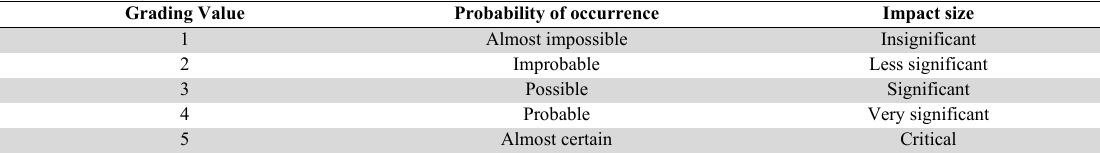
Risk Grading scale